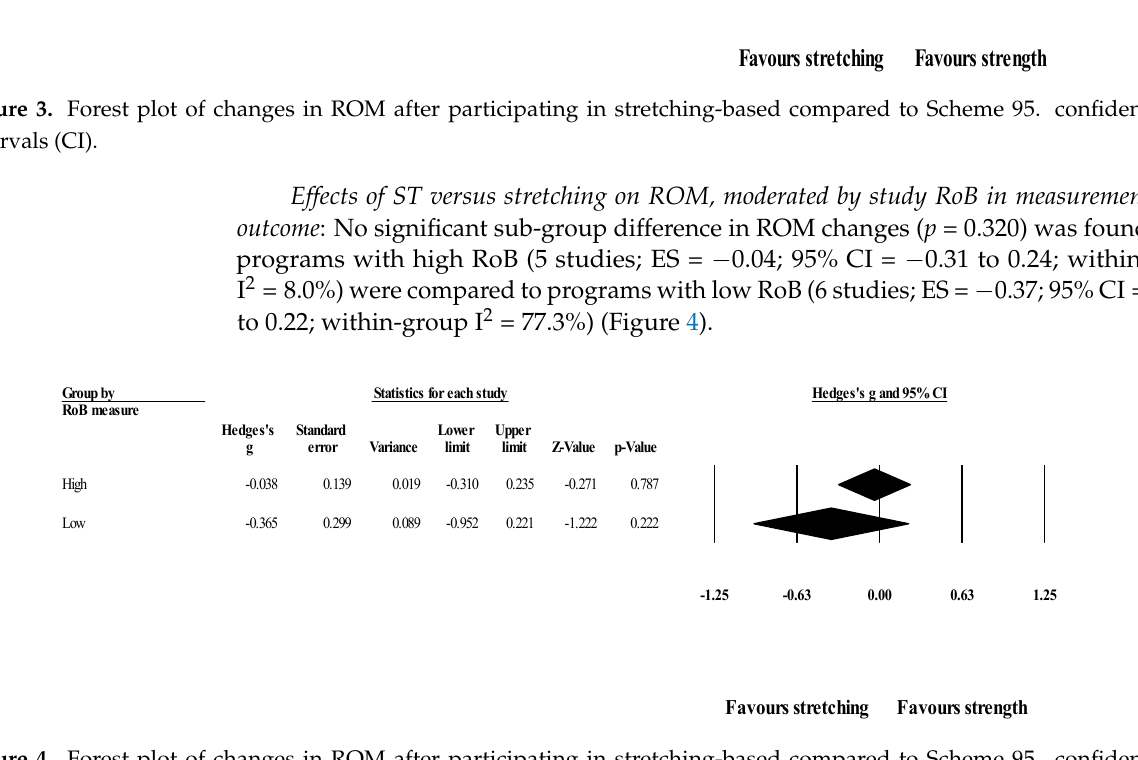
Figure 4. Forest plot of changes in ROM after participating in stretching ‐ based compared to Scheme 95. confidence inter ‐ vals (CI).